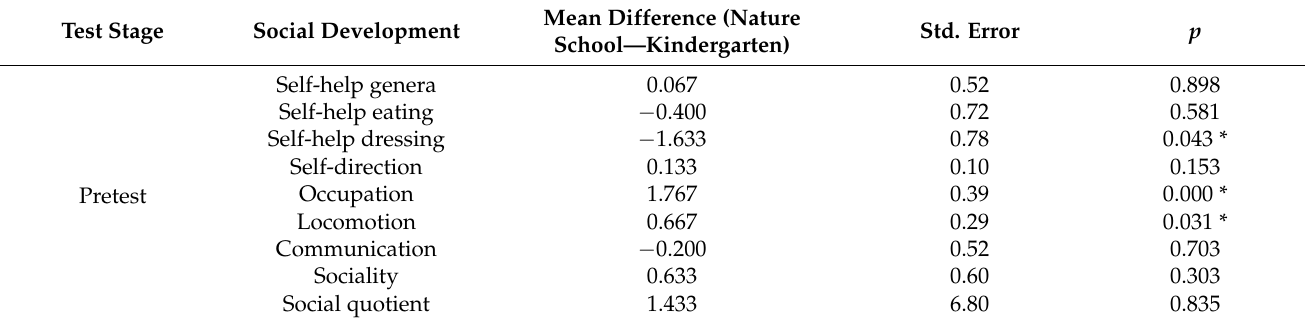
Table 3. Differences of social development between groups pre- and